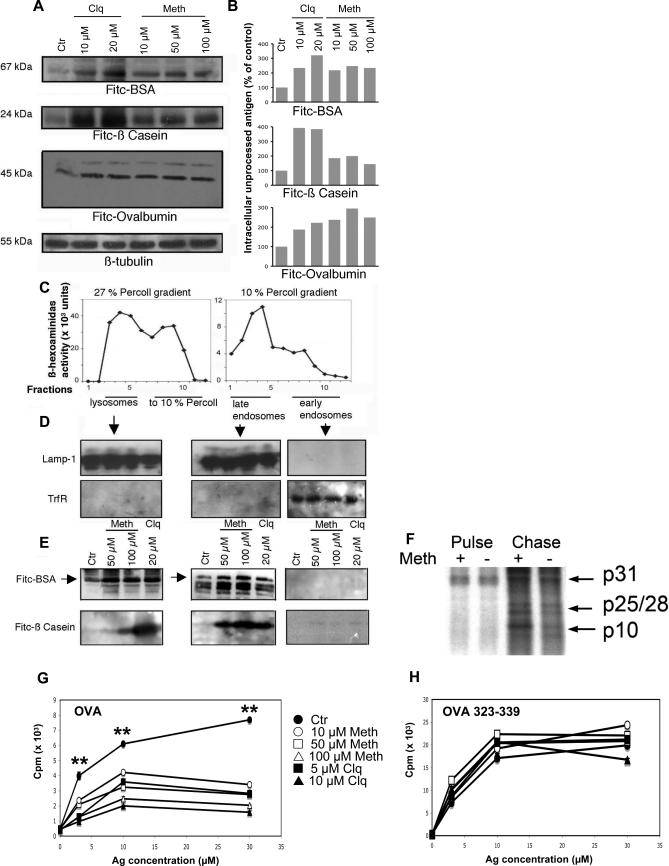
Meth Inhibits Endosomal Antigen Processing and MHC II Restricted Antigen Presentation(A) Western blots of bone marrow derived dendritic cells which phagocytosed FITC-labeled BSA, casein or OVA overnight, and exposed to Clq or Meth. Unprocessed antigens are quantified using anti-FITC mAb.(B) Densitometric analysis of western blots for the amount of unprocessed intracellular antigen. Representative of two to three independent experiments.(C) β-hexosaminidase activity measured in sub-cellular fractions to identify lysosomes and late endosomes.(D) Western blot using LAMP-1 and TrfR mAb on lysosomal, as well as early and late endosomal fractions.(E) Western blot analysis of the above pulled fractions from untreated, Clq- or Meth-treated dendritic cells using anti-Fitc mAb.(F) Immunoprecipitation of invariant chain in pulse-chase experiments. Full length invariant chain (p31) and degradation products (p25/28 and p/10) are indicated.(G) T cell proliferative response to bone marrow derived dendritic cells cultured with OVA protein (0, 3, 10, and 30 μM) in the absence (Ctr •) or presence of Meth (10 ○, 50 □, 100 μM ▵) or Clq (5 ▪ , 10 μM ▴) for 6 h, and cultured with T cells for 3 d. [3H]-Thymidine incorporation was used to assay T cell proliferation. (Statistics n = 4, mean ± SEM, **p < 0.001, two-tailed ANOVA.)(H) T cell proliferative response to bone marrow derived dendritic cells cultured with OVA peptide 323–339 (0, 3, 10, and 30 μM) in the absence (Ctr •) or presence of Meth (10 ○, 50 □, 100 μM ▵) or Clq (5 ▪ , 10 μM ▴) for 6 h, and cultured with T cells for 3 d.